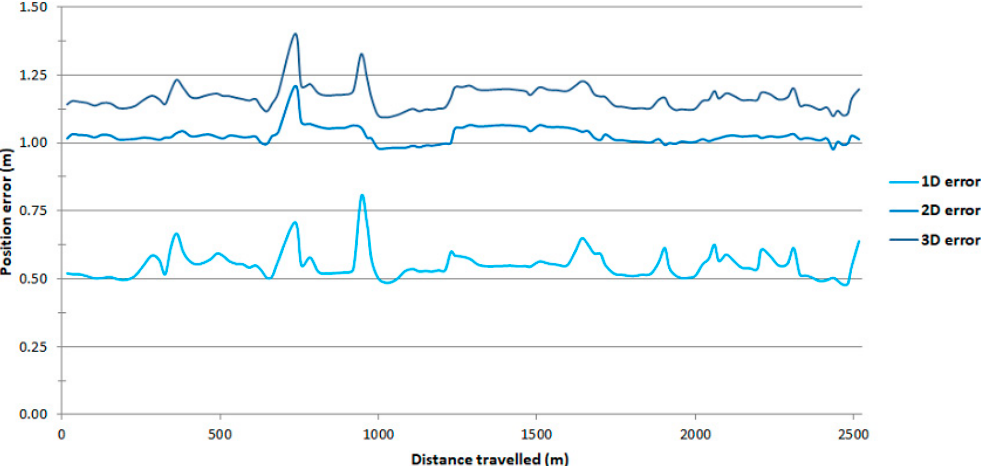
Figure 11. Variability of the 1D, 2D and 3D position errors recorded using the Ellipse-D system in the DGPS mode on route no. 2.